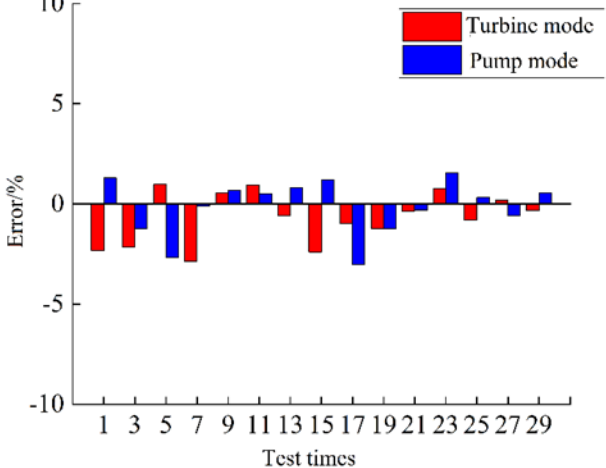
Figure 6. Error between integrated flow and flow meter flow.